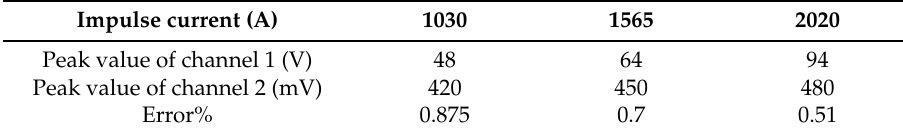
Table 6. Test results of vertical magnetic field interference.